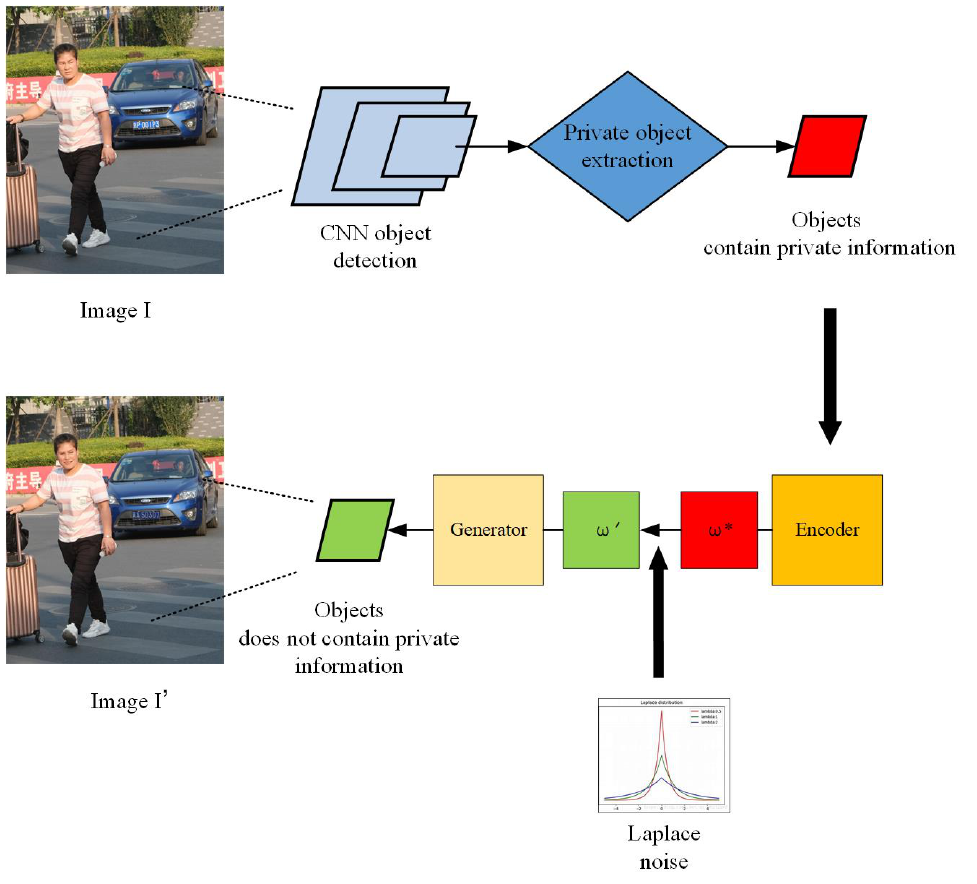
Figure 4. The diagram of the proposed image de-identification (DE-ID)